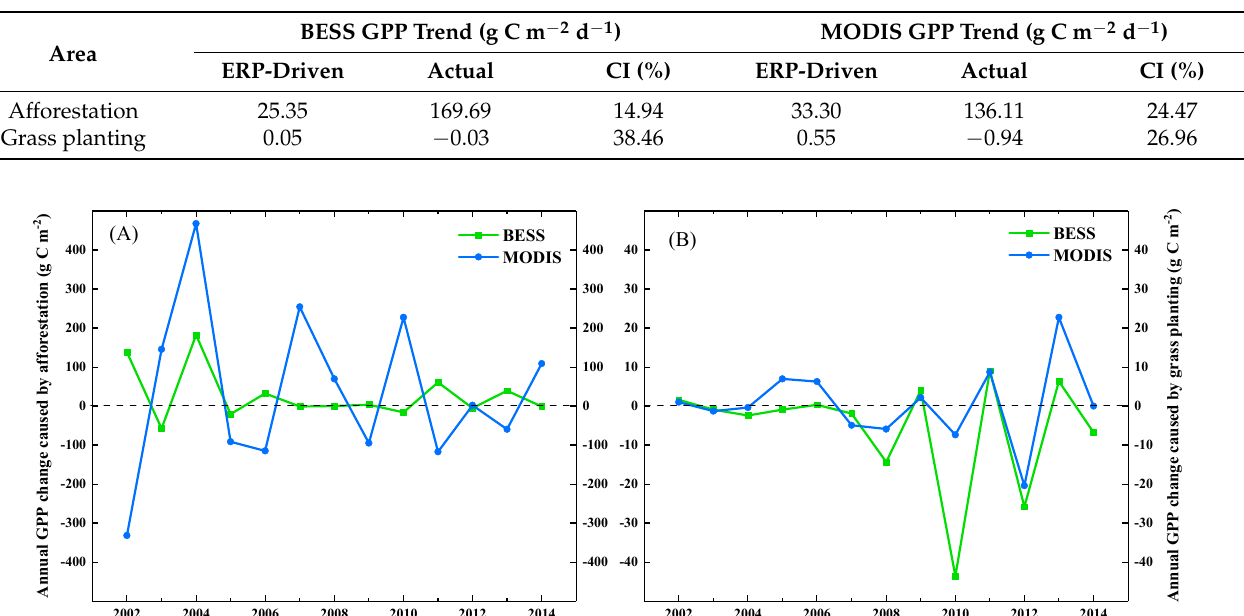
Figure 9. Annual GPP changes caused by ( A ) afforestation and ( B ) grass planting during the period of 2001–2015.